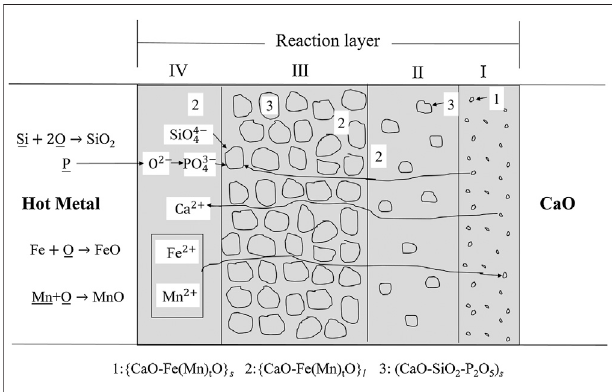
FIGURE 1 | Schematic illustration of lime dissolution and dephosphorization process (Ono et al., 1983) [Figure 6 of (Ono et al., 1983), Copyright The Iron and Steel Institute of